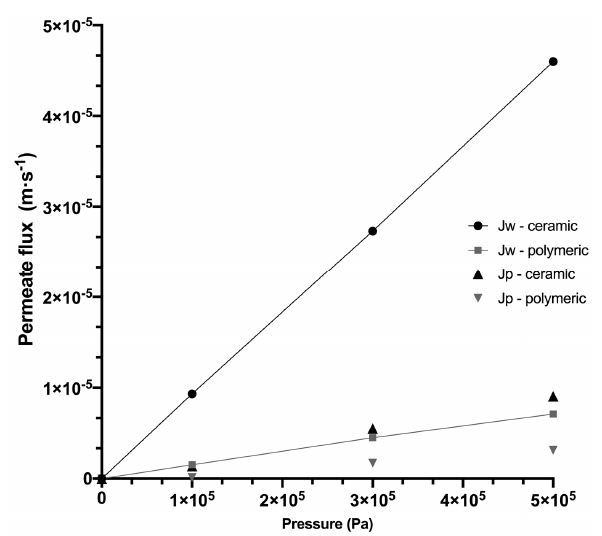
Figure 4. Variation of water flux ( J w ) and fructan permeate fluxes with transmembrane pressure for ceramic and polymeric membrane systems, at feed flow of 1.8 m 3 ·h − 1 and 318.15 K. During the UF of agave fructan solution, the evolution of the permeate fluxes with TMP follows a behavior similar to that obtained with pure water, but at a lower flux scale, where the differences between both systems are less radical, but maintain a greater flux in the ceramic membrane. The flux drop between pure water and agave solutions was due to the presence of solutes that involve concentration polarization phenomena in the boundary layer of the membrane. Similar results were found by Grangeon and Lescoche (2000) [40] when comparing tubular ceramic membranes with ceramic flat membranes under identical conditions of temperature, TMP and MWCO, where the highest permeate flux was obtained with the tubular membranes, resulting from the highest tangential velocity used. This is also consistent with Cheryan (1998) [55], who reports tangential velocity values of 7 m·s − 1 for ceramic tubular membranes and 1 m·s − 1 for polymeric membranes. Table 3. Experimental conditions for the tight ultrafiltration process.